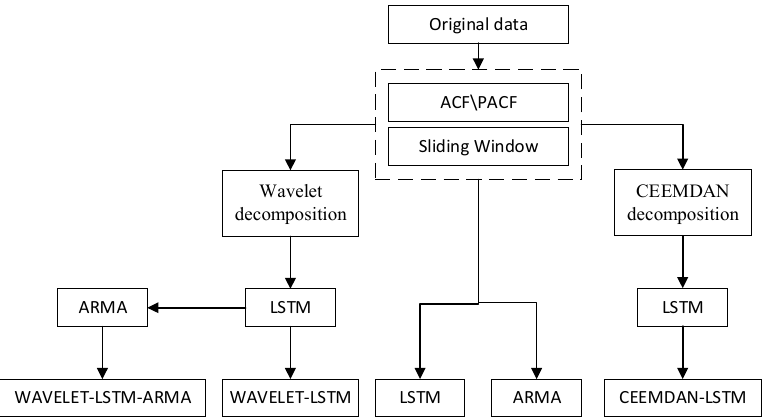
Figure 5. Analytical comparison model.